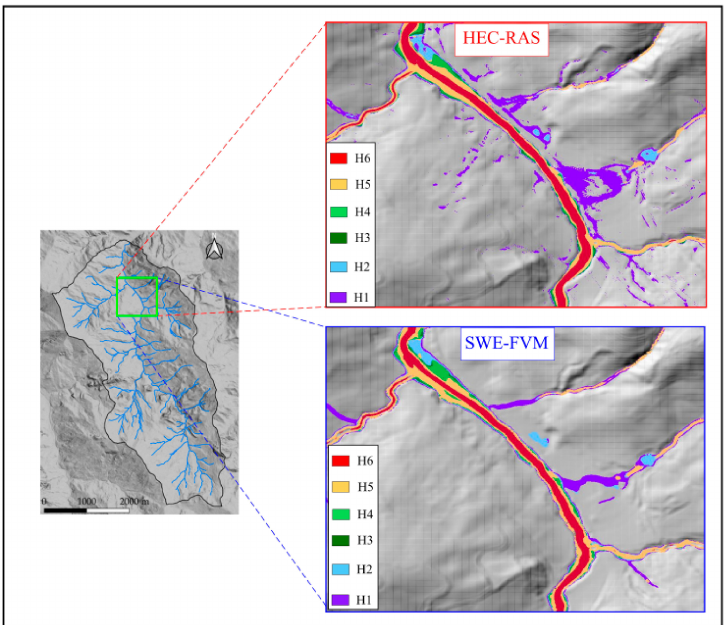
Figure 10. Hazard maps computed by HEC-RAS and SWE-FVM for water depth threshold equal to 0.05 m, considering T = 200 years and grid size 5 m.